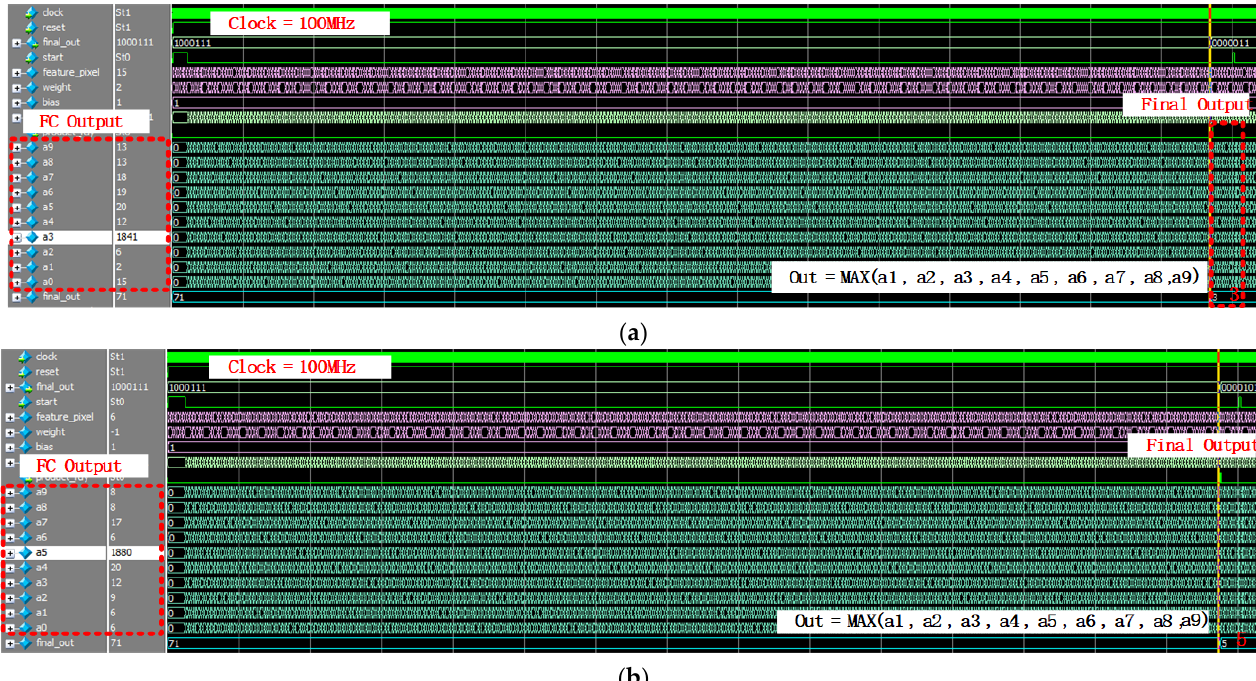
Figure 19. The simulation result of fully connected operation.